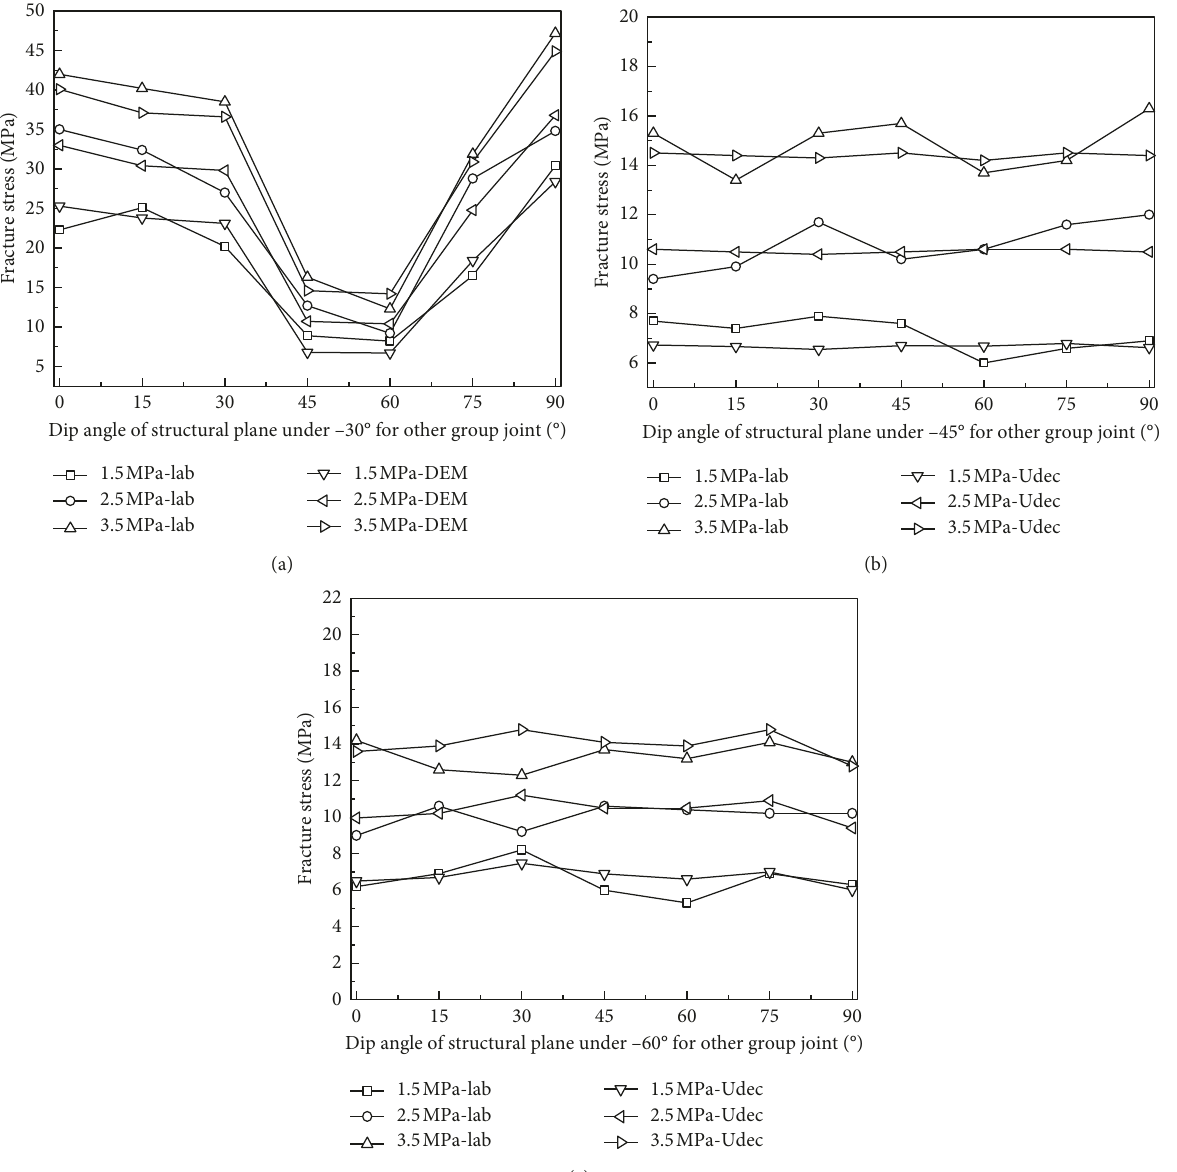
Figure 5: Comparison among numerically simulated and laboratory measured fracture stress value of rockmass with dip angles of (a) − 30 ° , (b) − 45 ° , and (c) − 60 ° under different confining pressures (lab refers to laboratory value, and DEM refers to discrete element numerical simulation